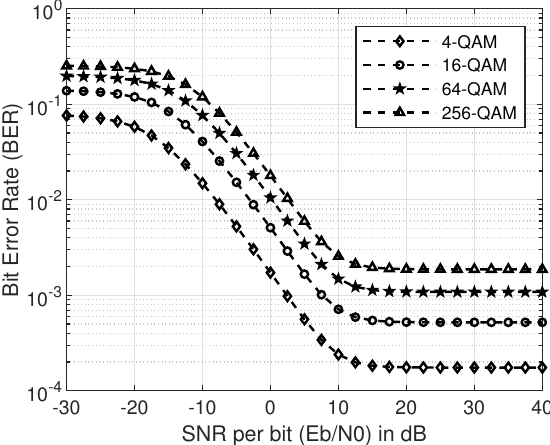
Figure 4. BER of M-QAM for no-collision case with IT ( q = 10